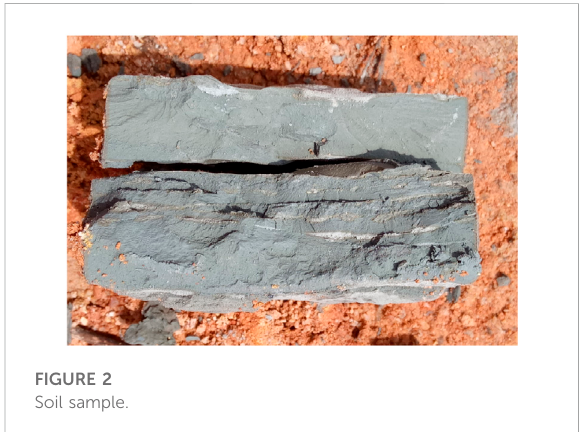
FIGURE 2 Soil sample.